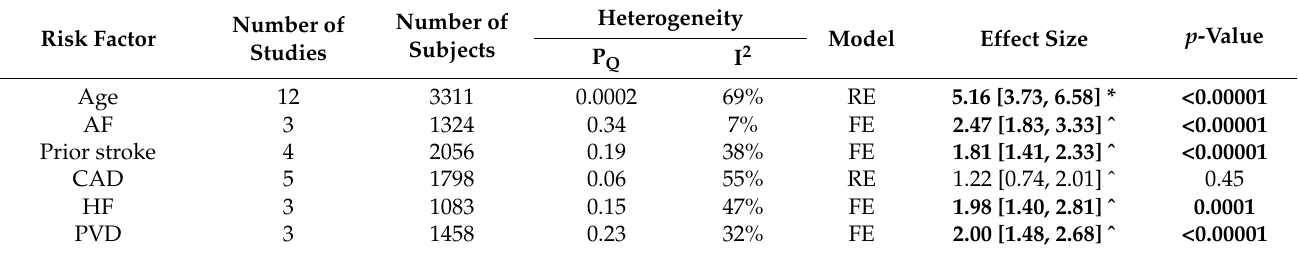
Table 2. Results of the current meta-analysis for the ischemic stroke/TIA patients.